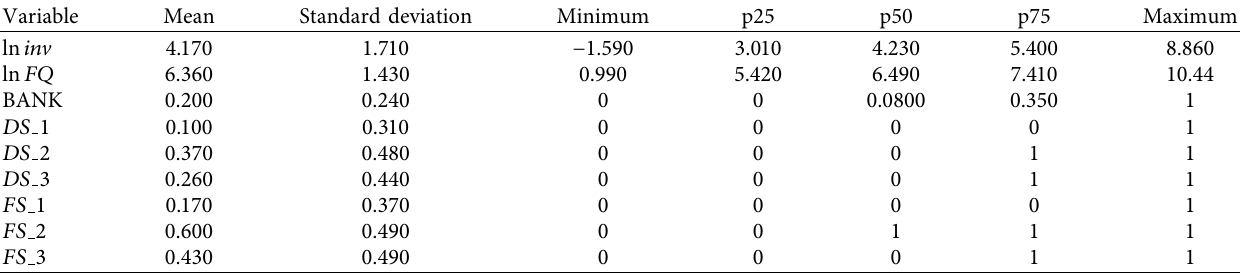
Table 2: Descriptive statistics of the main variables.